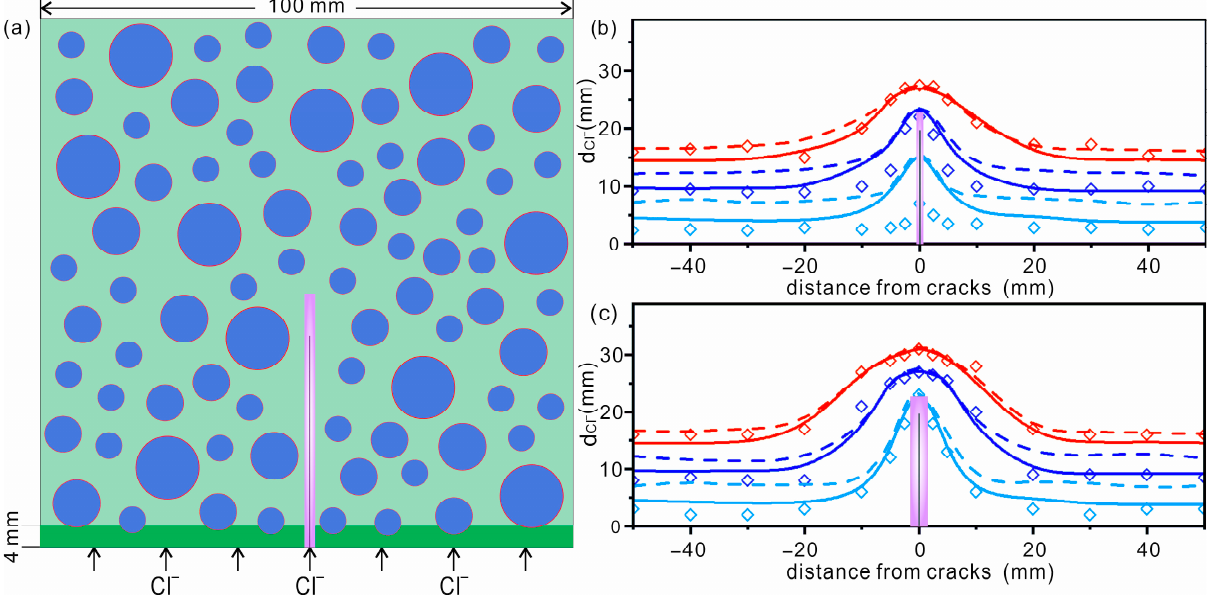
Figure 10. ( a ) The same mesoscale schematic model of concrete is considered, except for a 4 mm thick protecting layer (PL, highlighted with green zone). ( b , c ) Outermost diffusion contours of chloride in concrete with AC widths of 80 µm ( b ) and 200 µm ( c ). Light blue, blue and red represent data collected at 6, 18.5 and 37 days, respectively. Simulated data with and without the PL are shown as solid and dashed lines, respectively. Experimental results (diamonds) taken from [14] (reproduced with permission from [14], copyright 2016 Elsevier) are also shown for comparison. The solid black line and the purple zone represent the AC and DZ, respectively.